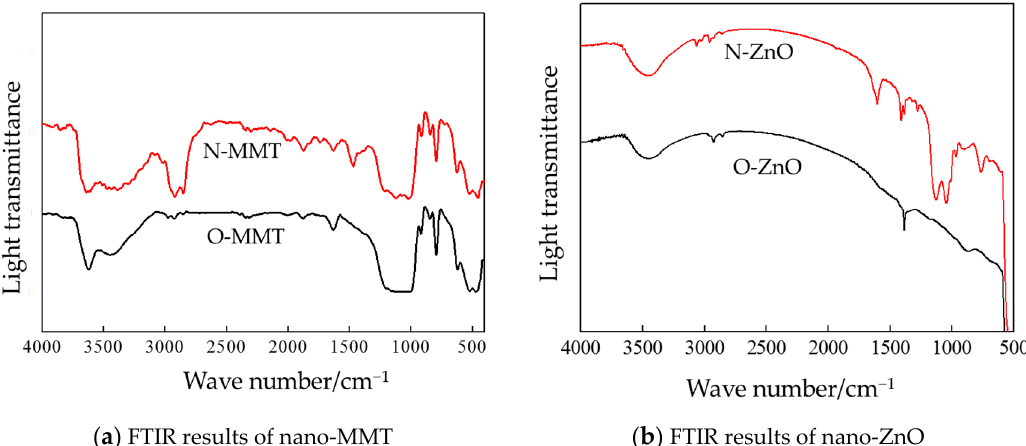
Figure 5. The Fourier-transform infrared spectroscopy (FTIR) results of different nanoparticles before